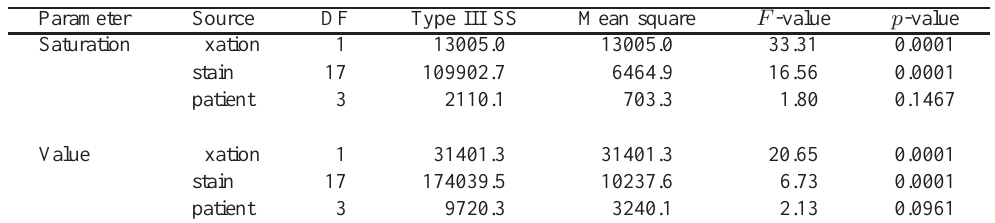
Table 5 Analysis of variance determining the significance of fixative, stain, and patient